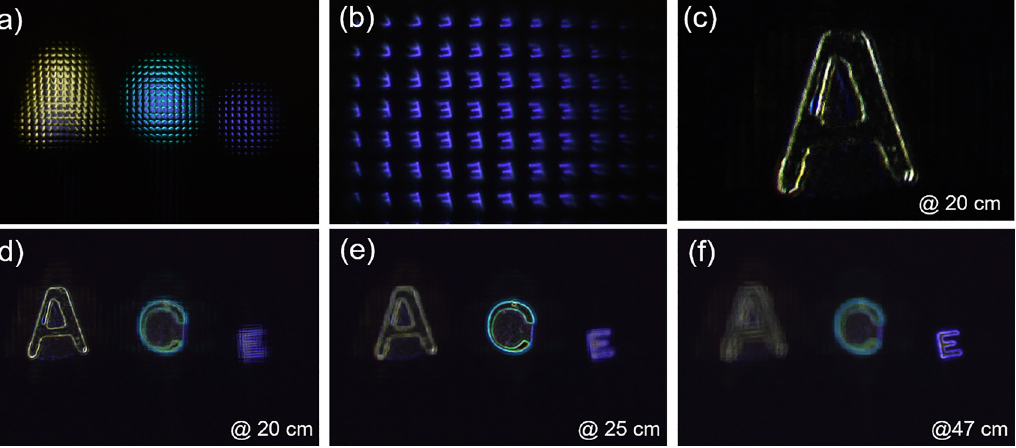
Figure 3: Experimental results of the edge detection light-field imaging. (a) Light field raw image formed by the achromatic meta-lens (b) the partial sub-images of the pattern ‘ E ’ . (c) The 1D edge image along the x -direction focused on the pattern ‘ A ’ . (d – f) The 3D edge images at different focused depths for patterns, ‘ A ’ , ‘ C ’ , and ‘ E ’